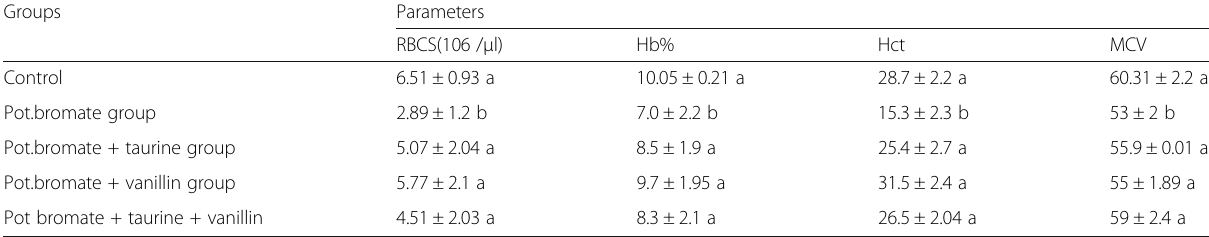
Table 5 Effect of taurine and/or vanillin on RBCS count, Hb%, Hct, MCV, and MCH values in the potassium bromate-treated rat